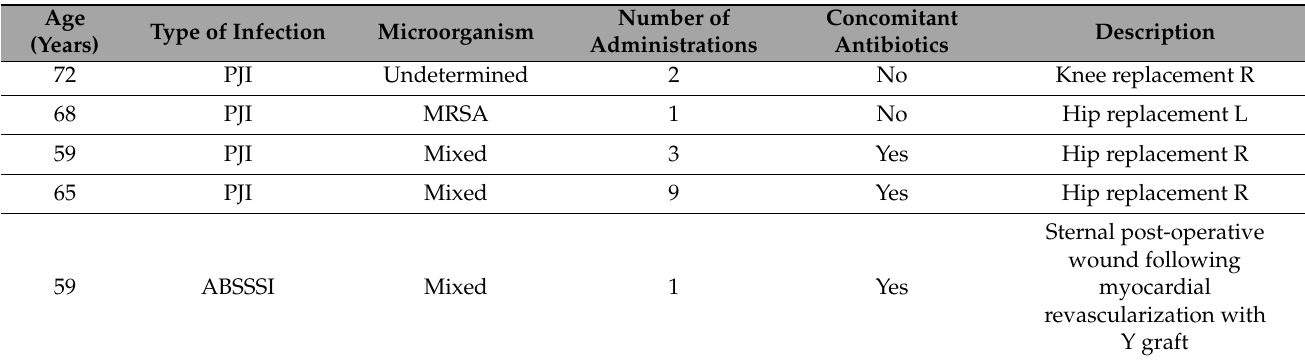
Table 3. Characteristics of patients who failed